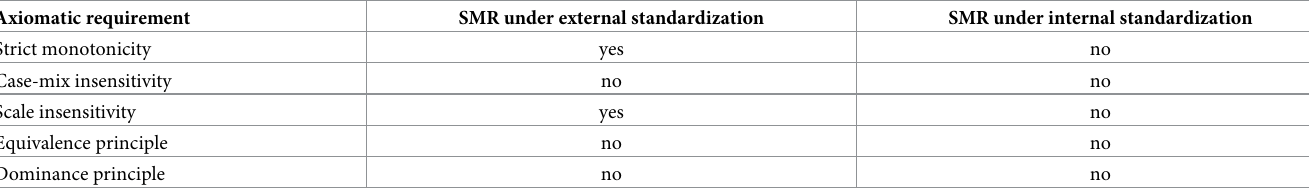
Table 8. Fulfillment of axiomatic requirements by standardization